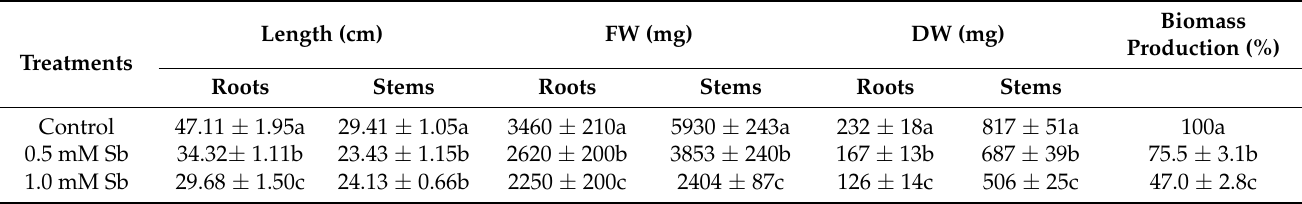
Figure 1. Dittrichia viscosa plants subjected to Sb toxicity for 17 days. Table 1. Effect of Sb on the length, fresh weight, and dry weight of roots and stems, and on total biomass production in D. viscosa plants. The data are from 10 independent experiments, each carried out in triplicate (different letters indicate significant differences at p < 0.05, Mann–Whitney U-test).